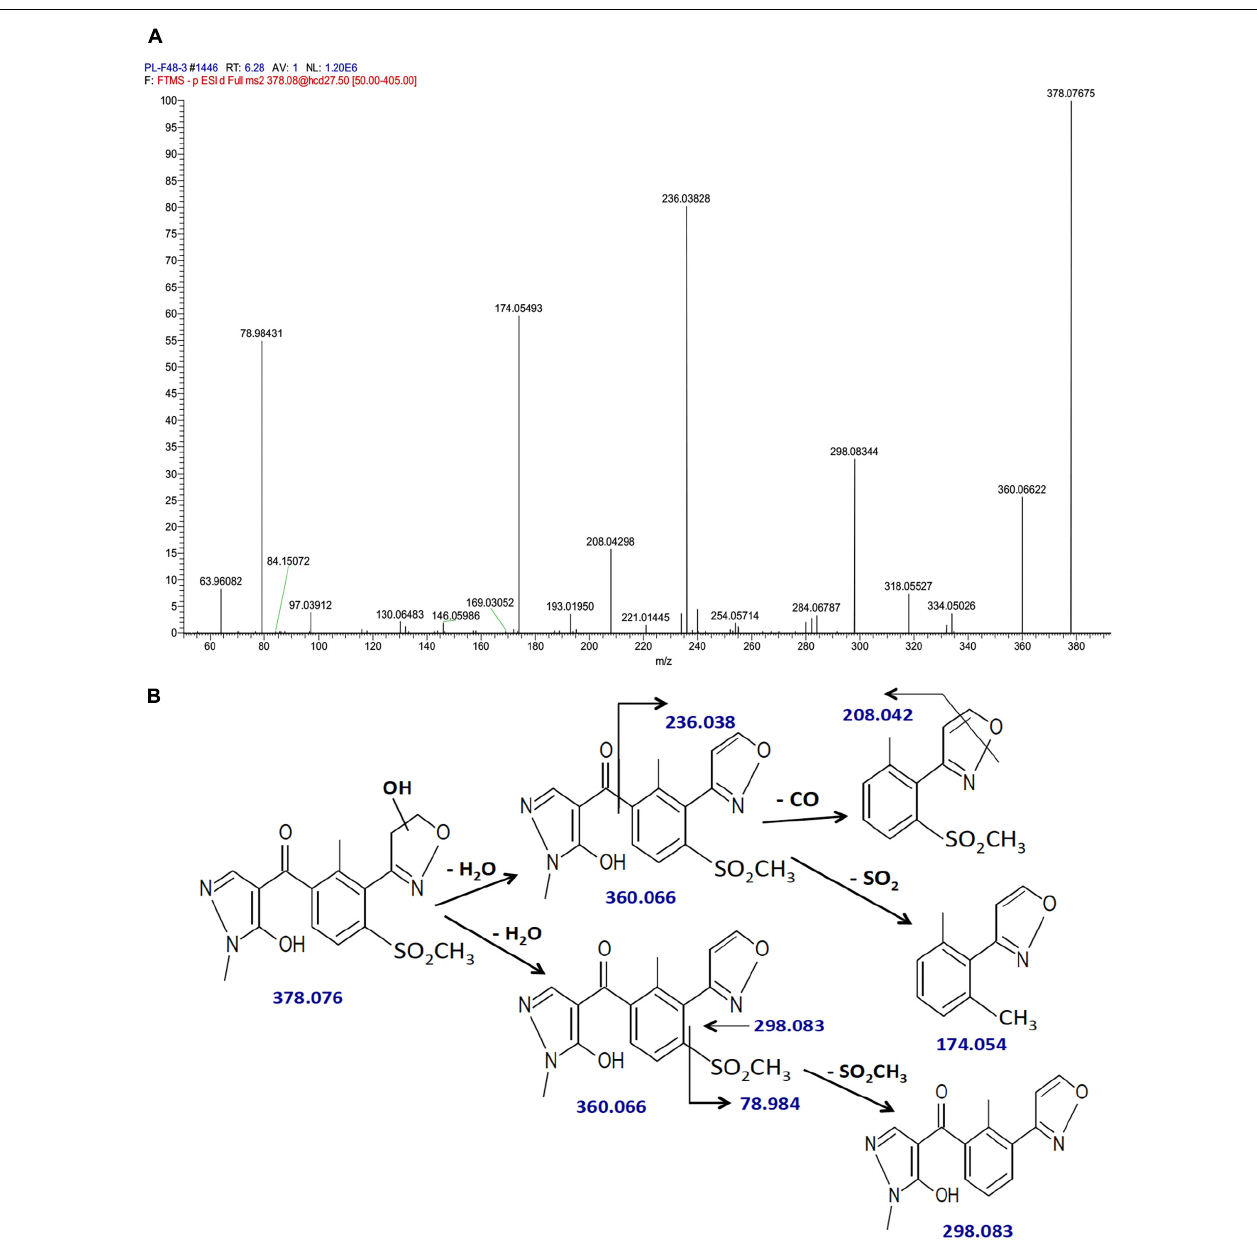
FIGURE 6 | Identification of hydroxytopramezone-1 metabolite formed in treated leaves of multiple herbicide-resistant waterhemp (SIR) 48 HAT using high-resolution LC-MS. The third- and fourth-youngest leaves from waterhemp and maize plants (10–12 cm tall) were treated with 60 × 0.33 µ L droplets (20 µ L total) of a 1.5 mM topramezone solution, including 0.1% (v/v) Tween 20 as a leaf wetting agent, using a glass syringe. Only the treated leaves were harvested from each plant (48 HAT), extracted and partially purified by SPE chromatography, then analyzed by LC-MS (high resolution) as described in Section “Materials and Methods.” Proposed fragment ions following the loss of –CO (Bouchoux and Hoppilliard, 1981), –SO 2 CH 3 and intramolecular SO 2 elimination (Chahboune and Sarakha, 2018) are supported by previous research investigating the fragmentation of isoxazole and mesotrione, respectively. (A) LC-MS/MS spectrum of